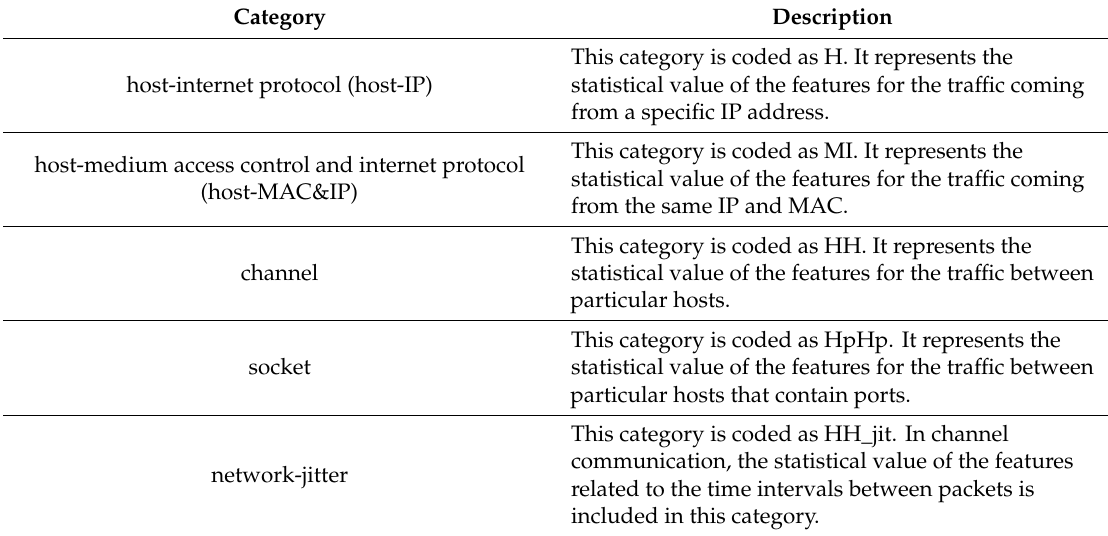
Table 1. Description of the dataset